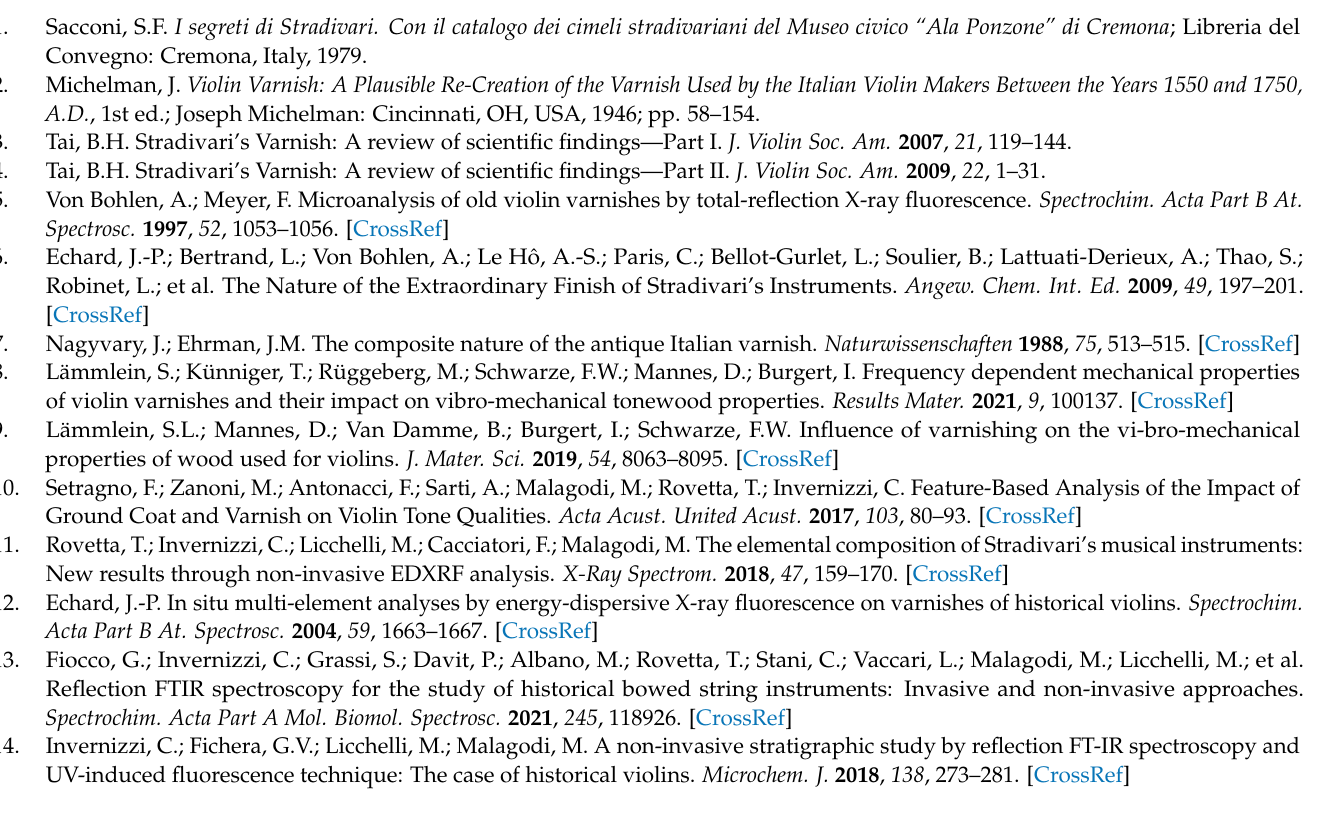
fluorescence levels. Figure S3: Legend of the measurement positions acquired on the violins. Table S1: Measurements obtained on the 3D models of the three violins. Measurement letters in the first column are related to the measurement positions shown in Figure